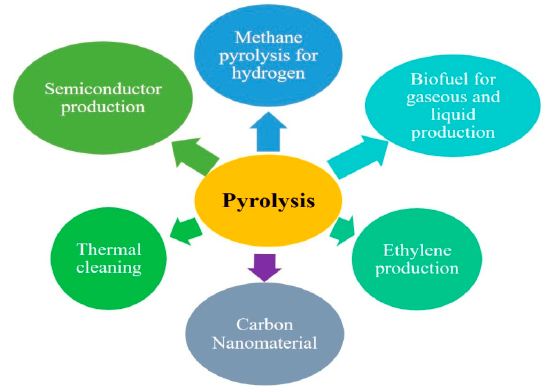
Figure 3. Products produced through the pyrolysis